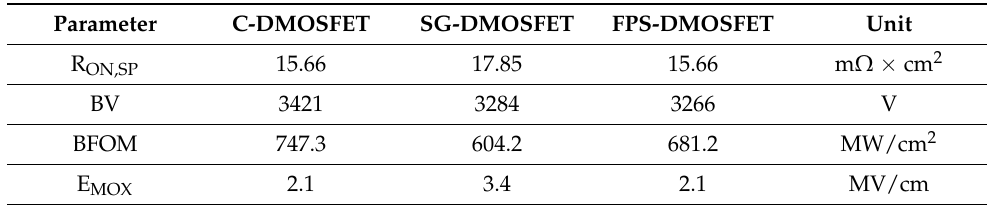
Figure 7. Static characteristics of the three structures. ( a ) output curve in the on state and ( b ) off state leakage current. Table 2. Static characteristics of three